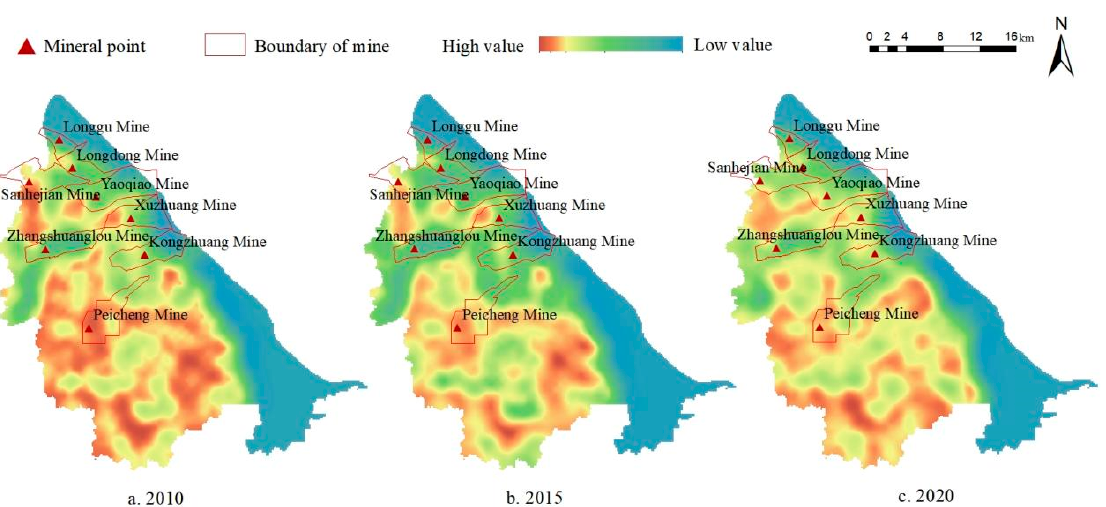
Figure 4. Spatial distribution of ER in 2010, 2015, and 2020.